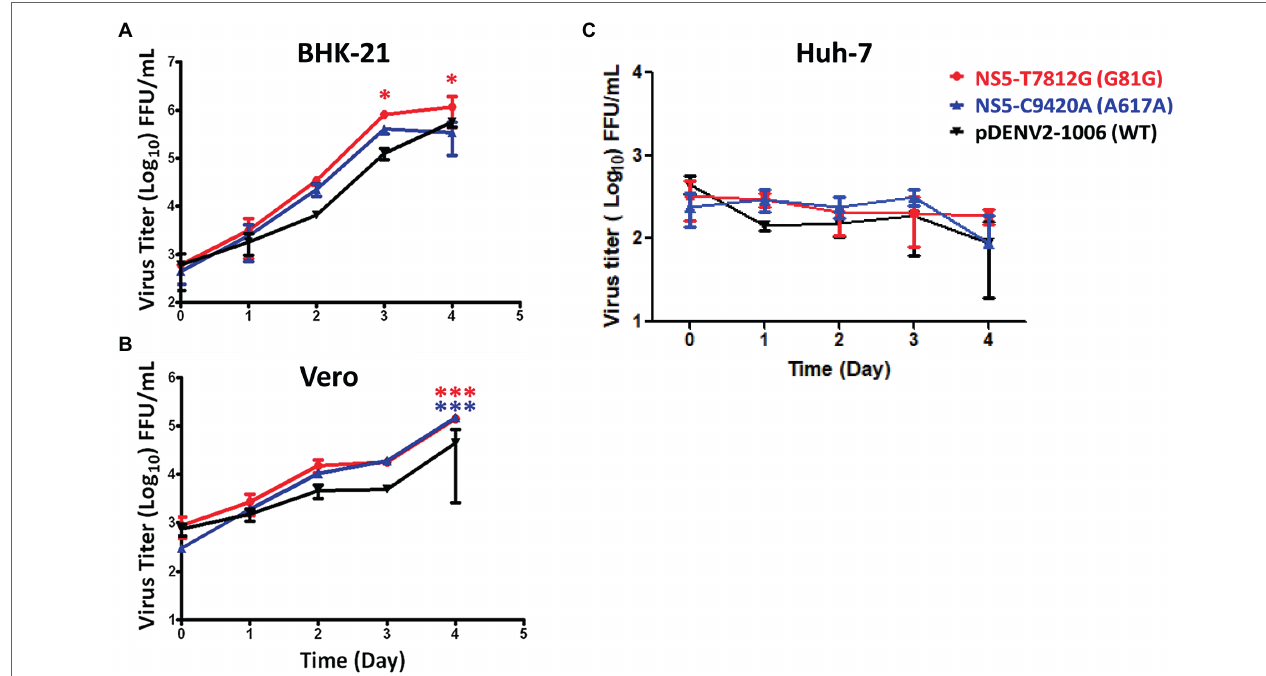
FIGURE 4 | Multiple-step replication cycle of DENV variants and WT. BHK-21 (A) , Vero (B) , and Huh-7 (C) cells were infected with viruses containing the variants and WT (pDENV2-1,006 NS5-7812 T/9420C) virus at a MOI of 0.01. Virus titers were quantified at 0-, 1-, 2-, 3-, and 4-days post infection via flow cytometry and ELISpot. Titers were calculated for FFU/mL. The circle, triangle, and inverted triangle symbols represent NS5-T7812G (G81G), NS5-C9420A (A617A), and pDENV2-1,006 (WT- NS5-7812 T/9420C) viruses, respectively. Statistical difference comparing mutants with wildtype was calculated using two-way ANOVA. * p < 0.05; *** p <